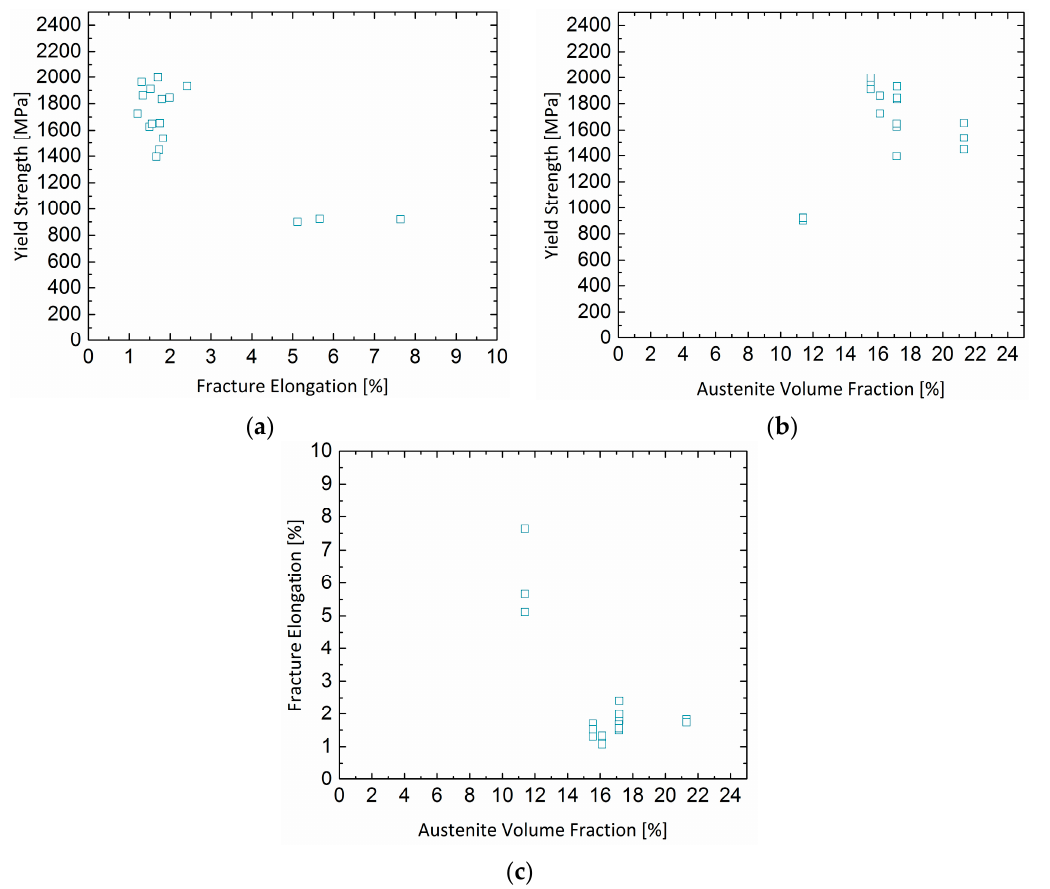
Figure 13. Relation between 0.2% yield strength, tensile elongation at fracture, and austenite volume fraction for the SLM processed 18 ‐ Ni 300 steel .